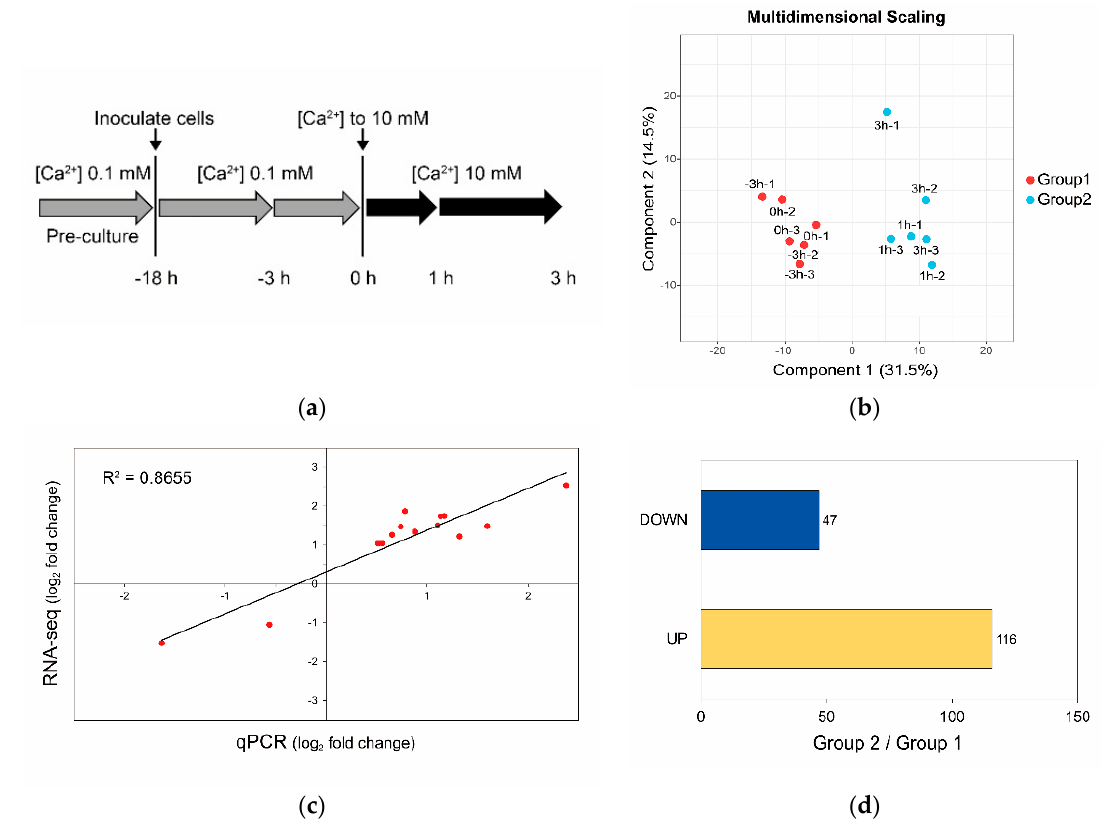
Figure 3. Transcriptomic analysis to identify genes that were upregulated with increasing calcium-induced coccolith production in E. huxleyi CCMP 371 cells. ( a ) The overall sampling protocol for RNA-seq uses the same experimental design as MS in Figures 1 and 2. ( b ) The multidimensional scaling plot categorized into two groups depending on sampling time before ( − 3 and 0 h, red dots) and after adding 10 mM [Ca 2+ ] (1 and 3 h, light blue); namely, group 1 involving non-calcifying cells grown at low [Ca 2+ ] conditions and group 2 involving Ca 2+ -induced calcified cells, respectively. ( c ) Analysis of differentially expressed genes (DEGs) by qPCR (biological triplicates, n = 3) vs. RNA-seq plot. ( d ) The numbers of upregulated (yellow) and downregulated (blue) DEGs in Group 2 compared with Group 1 (Group 2/Group 1).